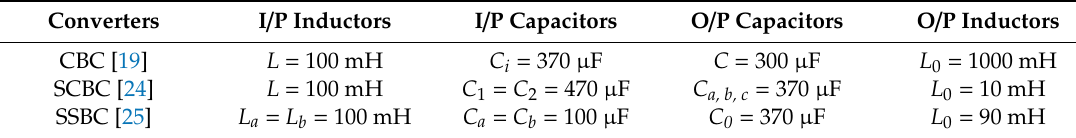
Table 5. Design parameters of a high step-up boost